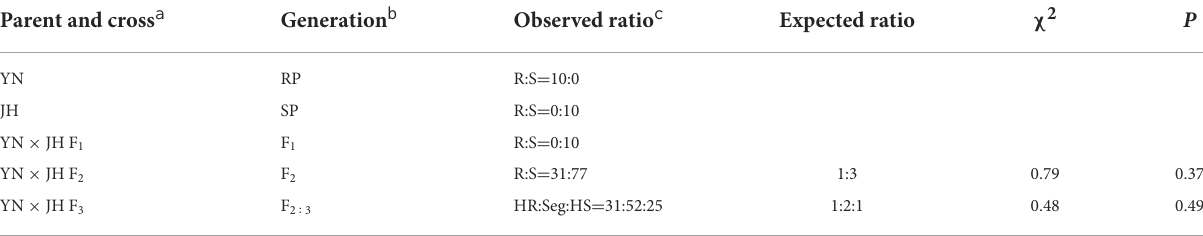
TABLE 3 Segregation ratios of F 2 and F 2 : 3 generations of Yannong 99102-06188 (YN) and Jinhe 13-205 (JH) following inoculation with Blumeria graminis f. sp. tritici ( Bgt ) isolate E09 at the seedling stage. Parent and cross a